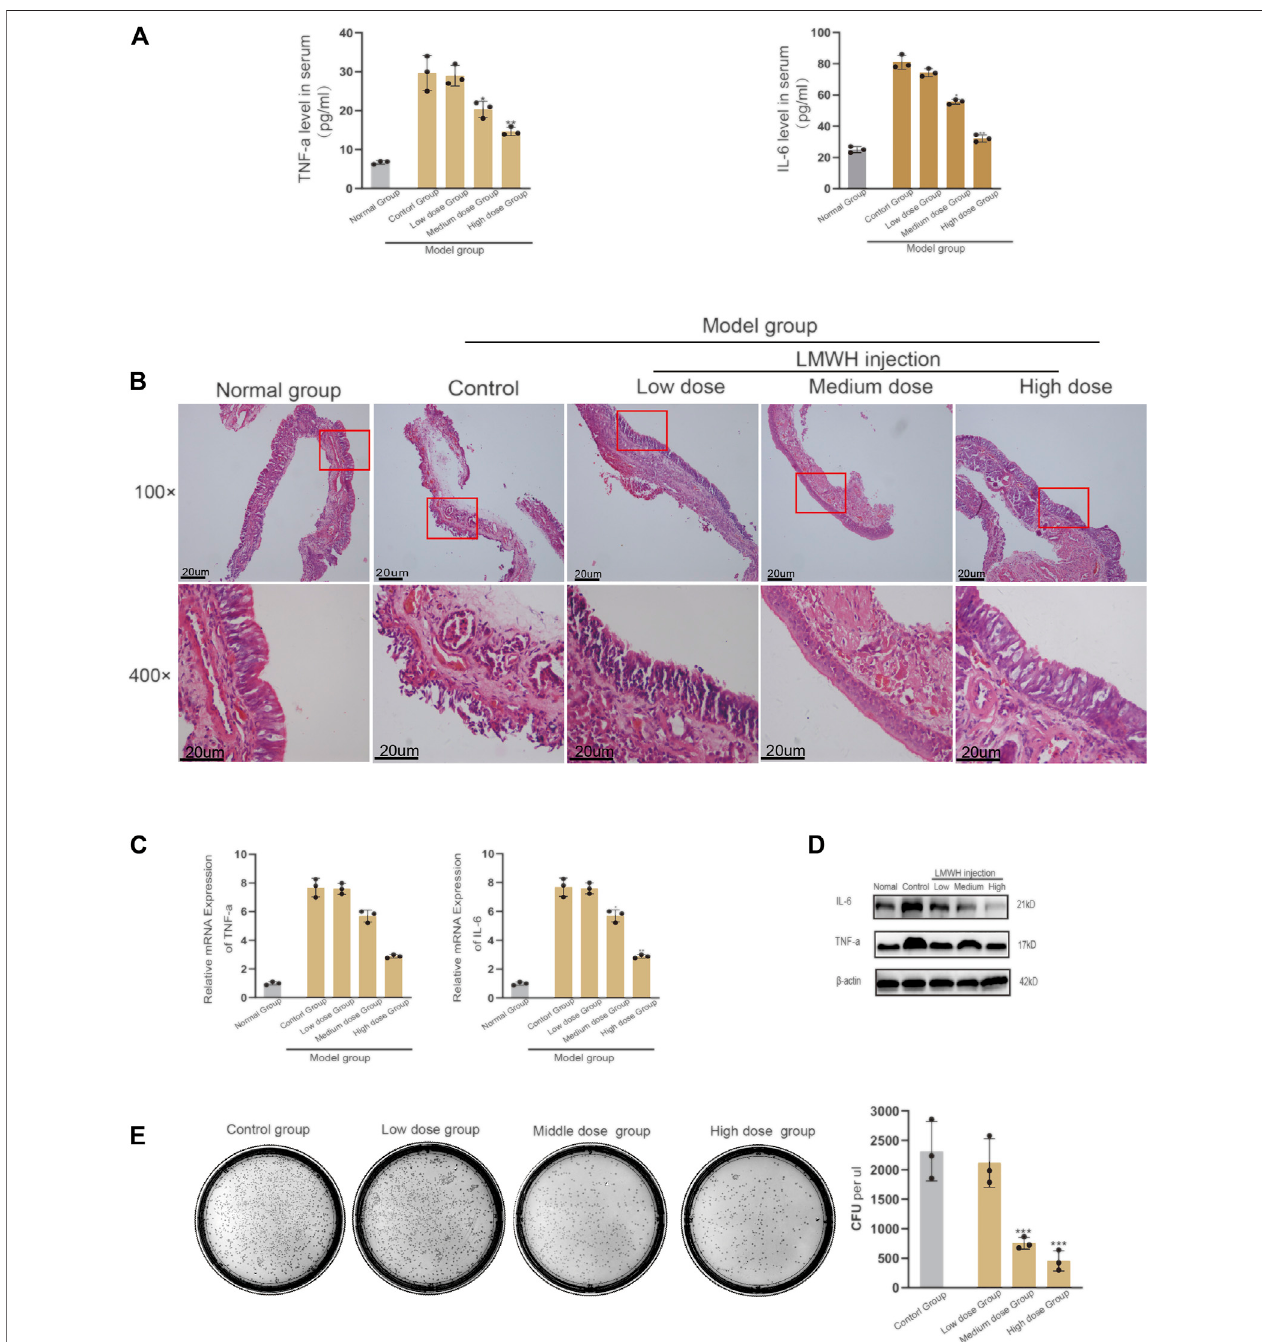
FIGURE 2 | Effect of abdominal injection of LWMH on acute sinusitis in rats. (A) Comparison of the relative concentrations of TNF- α and IL-6 in the serum of rats after abdominal injection of LMWH at different concentrations. (B) H&E staining results of nasal mucosa of rats in each group after abdominal injection of LMWH at differentconcentrations. (C) mRNAlevelofTNF- α andIL-6wasdetectedbyquantitativeRT-PCR. (D) ProteinexpressionlevelsofratsafterabdominalinjectionofLMWH at different concentrations by Western blot. (E) Bacterial culture and comparison of colony number of sino-nasal lavage samples of rats in each group. Note: Low dose (cid:1) 75 u/kg, Medium dose (cid:1) 150 u/kg, High dose (cid:1) 300 u/kg. ***compared with control group p < 0.001. The experiment was repeated three times.